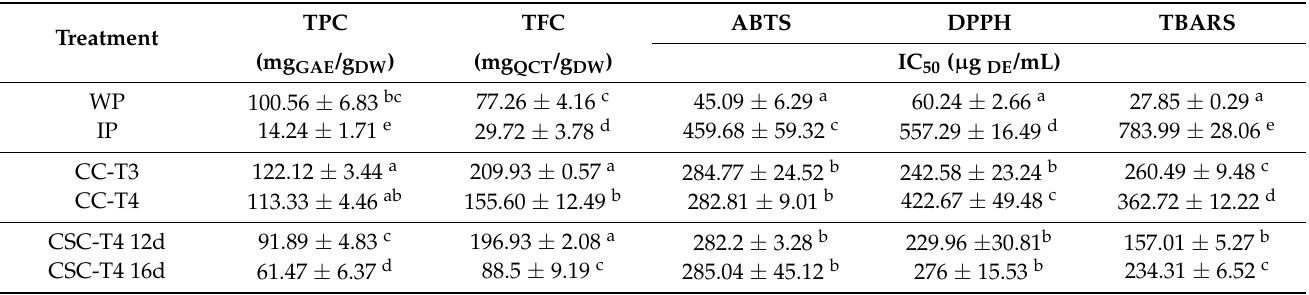
Table 2. Phytochemical characterization and antioxidant activity of extracts from A. pichichensis and its cell